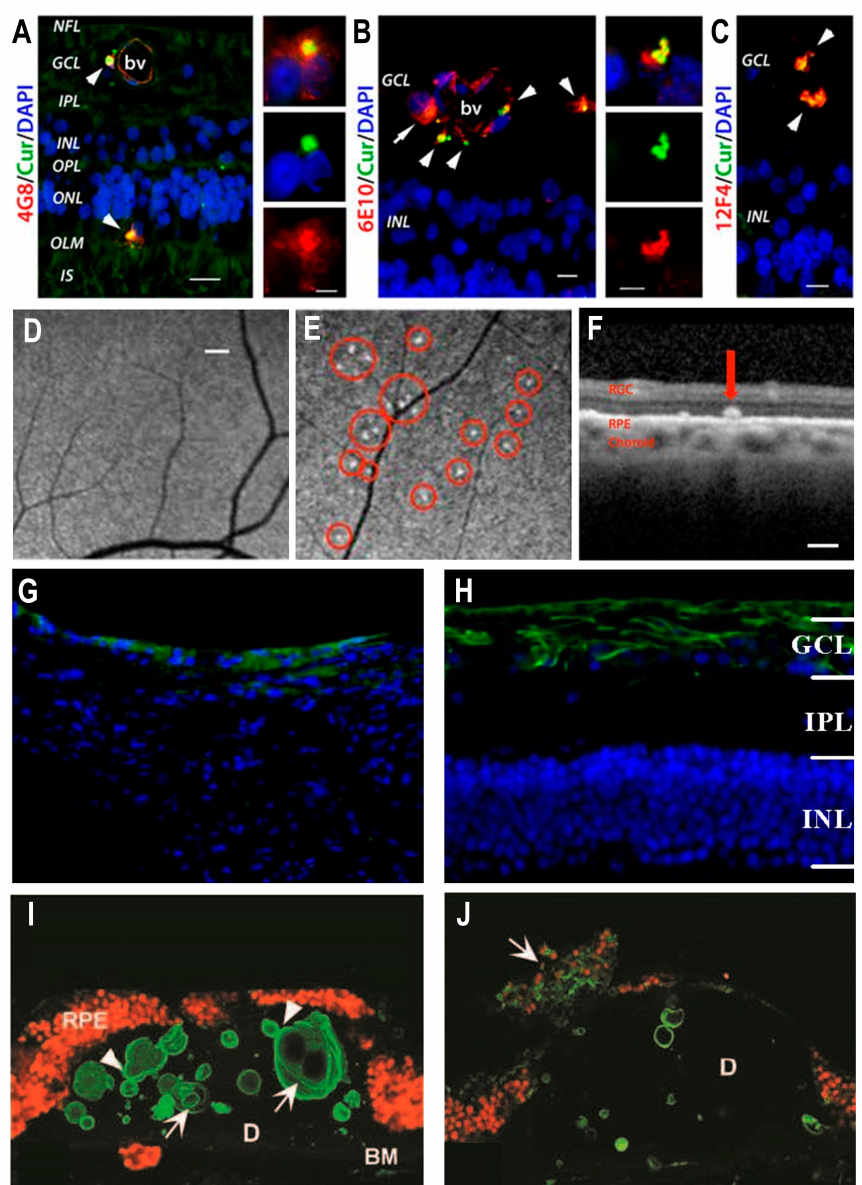
Figure 1. Amyloid- β (A β ) accumulations in the retina for Alzheimer’s disease (AD), glaucoma, and age-related macular degeneration (AMD). ( A – F ) A β deposits in relation to AD patients (Cited and modified from [30], used under an open-access license agreement). ( A – C ) In retinal donor tissue from AD patients, A β accumulations are identified through anti-A β monoclonal antibodies (4G8, 6E10, 12F4) and curcumin in multiple retinal layers and especially in the ganglion cell layer. In vivo imaging with curcumin fluorescent probe for ( D ) healthy subject and ( E ) AD patient with A β accumulations circled in red. ( F ) Curcumin-positive deposit identified above retinal pigment epithelium (RPE) for AD patients in vivo. ( G , H ) A β deposits in primate glaucoma model (Cited and modified from [68] used under an open-access license agreement). Anti-A β immunostaining show A β deposits (green) in ( G ) optic nerve and ( H ) retinal layers, predominantly in the ganglion cell layer. ( I , J ) A β deposits in AMD retinal donor tissue (Cited and modified from [102] used under an open-access license agreement). A β accumulations identified through anti-A β monoclonal antibody (green) in ( I ) amyloid vesicles inside drusen located between the RPE and Bruch’s membrane and ( J ) in the